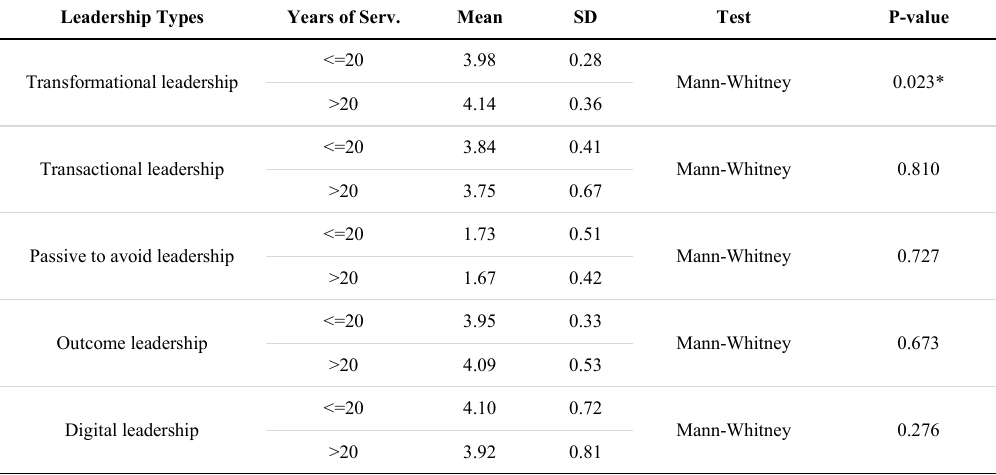
Table 5. Leadership Types per Years of Service.